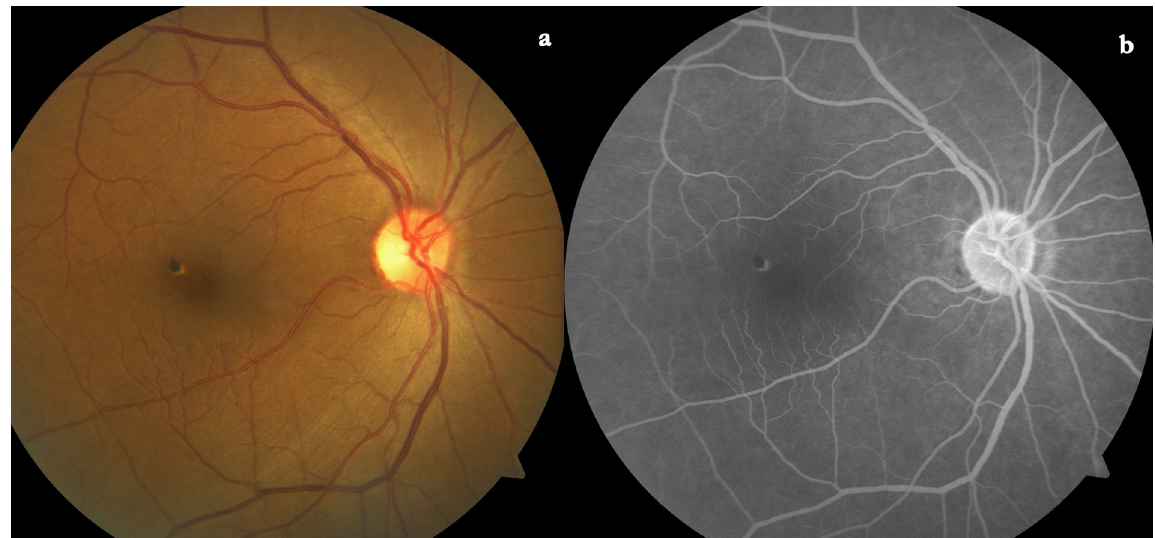
Figure 1: a) The fundus photo shows the sharply defined small pigmented lesion. b) The fluorescein angiogram showed block fluorescence at the area of pigmentation and window defect at the marginal depigmentation.